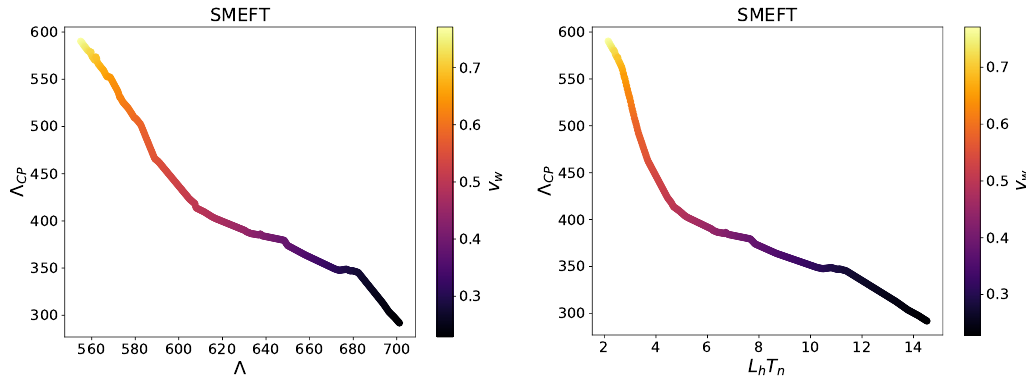
Figure 13 . Cut-off scale Λ CP necessary to produce the observed BAU as a function of the cut-off scale of the scalar potential (left) and of the bubble wall thickness (right) in SMEFT